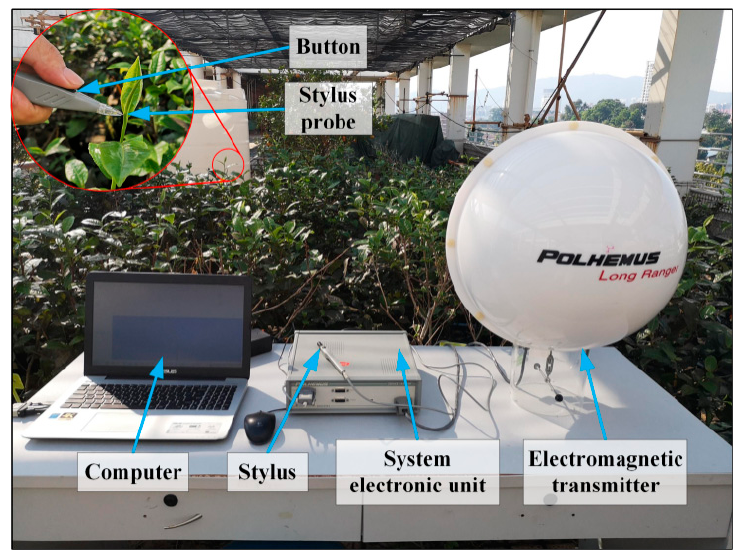
Figure 2. The 3-D coordinate acquisition system.